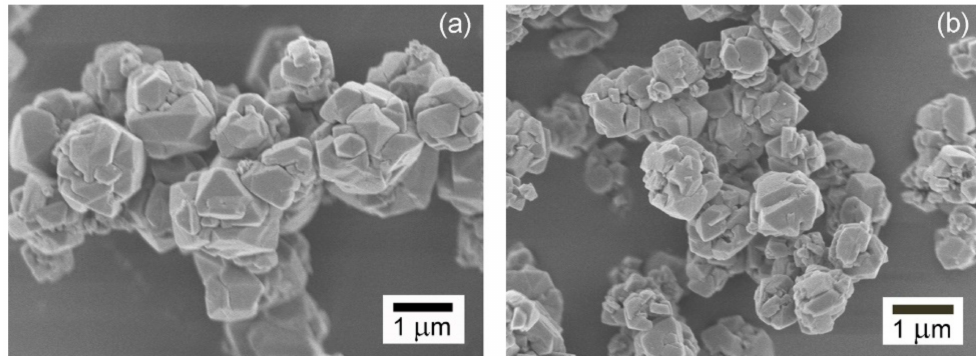
Figure 4. The crystal morphologies of NaX zeolites synthesized by: ( a ) magnetic induction heating; ( b ) convection oil bath heating.